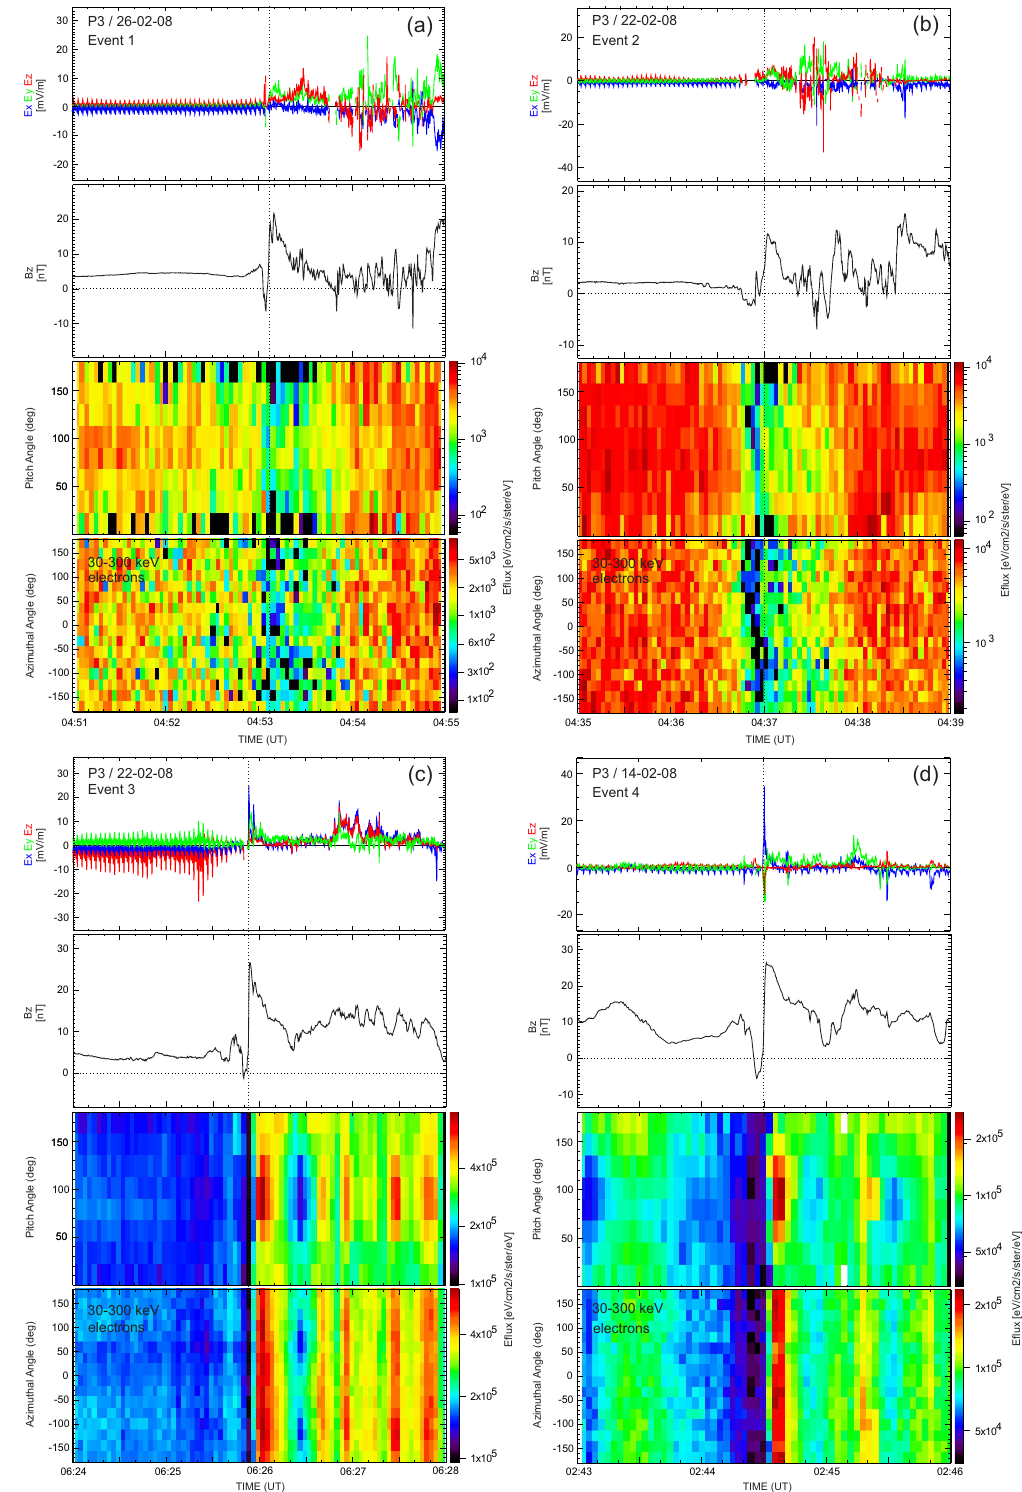
Fig. 7. Time-zoomed plots of all four individual dipolarization front events for energetic electrons only. Each plot consists of four panels. Electric field components and B z magnetic field component in GSM coordinates are plotted in the first two panels of each plot with a 0.125 and 0.25s time resolution, respectively. The third and fourth panels of each plot present electron differential energy fluxes versus pitch and azimuthal angle, respectively, measured by the SST instrument in the 30–300keV energy range. The vertical dashed lines denote the inductive electric fields associated with the dipolarized flux tubes/dipolarization